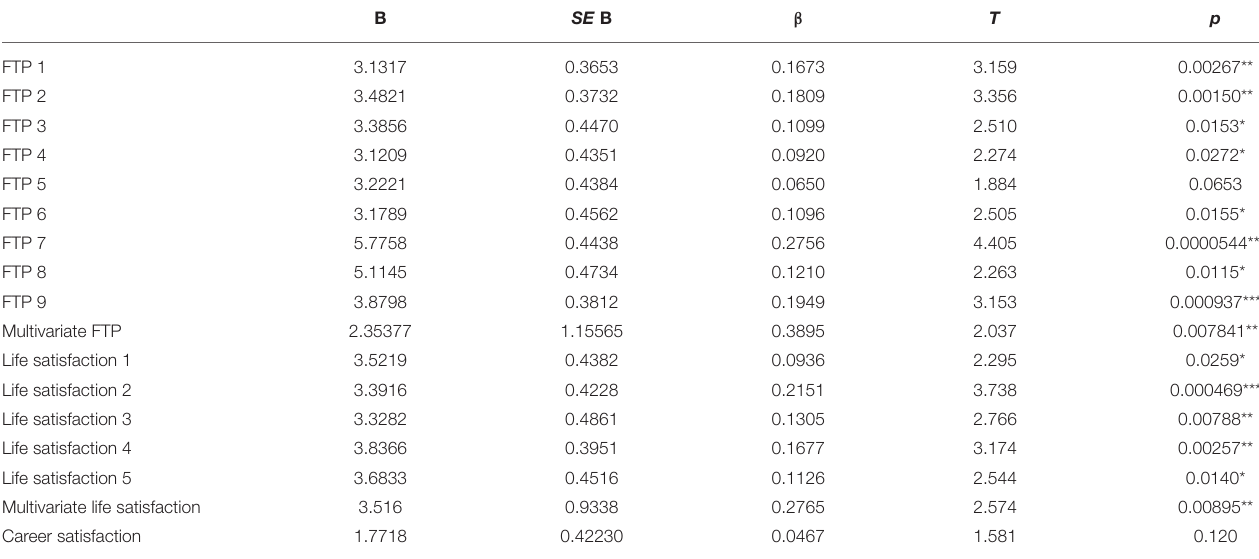
TABLE 1 | Logistic regression between the question “how many musician colleagues do you regularly interact with professionally?” and measures of future time perspective (FTP), life satisfaction, and career satisfaction.